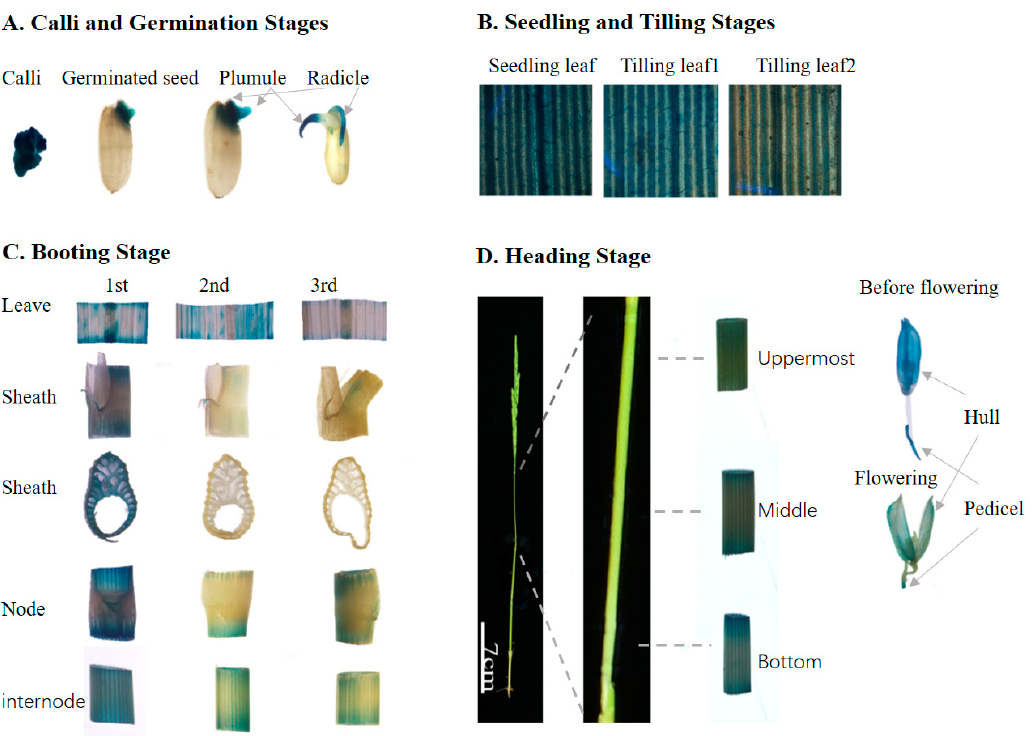
Figure 4. Analysis of β -glucuronidase (GUS) activity in the pOsBAG3::GUS transgenic plants. The GUS activity is shown in most tissue examined across the entire life circle. 1st, inverted 1st internode; 2nd, inverted 2nd internode; 3rd, inverted 3rd internode; Uppermost, upper fragments of the uppermost internode; Middle, middle fragments of the uppermost internode; Bottom, bottom fragments of the uppermost internode.